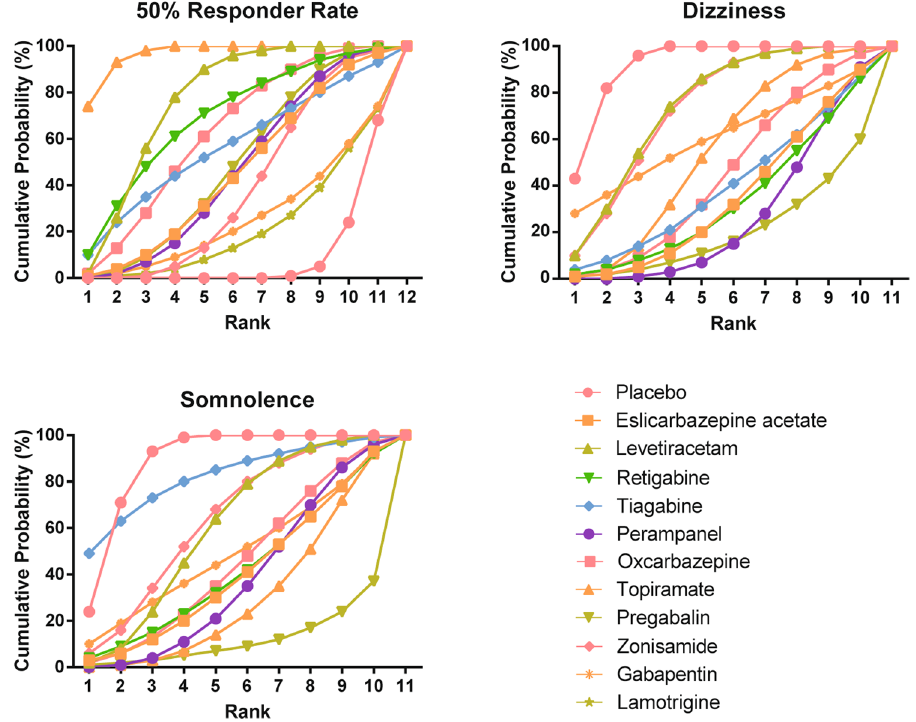
Figure 5. Cumulative probability diagram for 50% responder rate, dizziness, somnolence and headache.